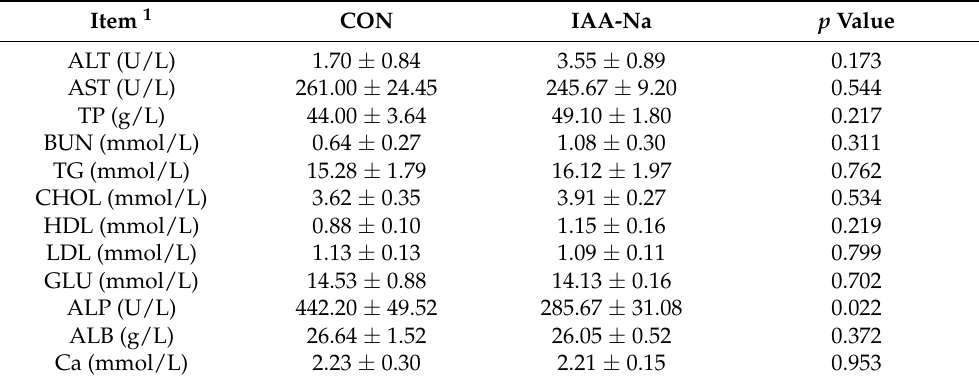
Table 5. Effects of dietary IAA-Na supplementation on serum biochemical levels in Danzhou chickens.